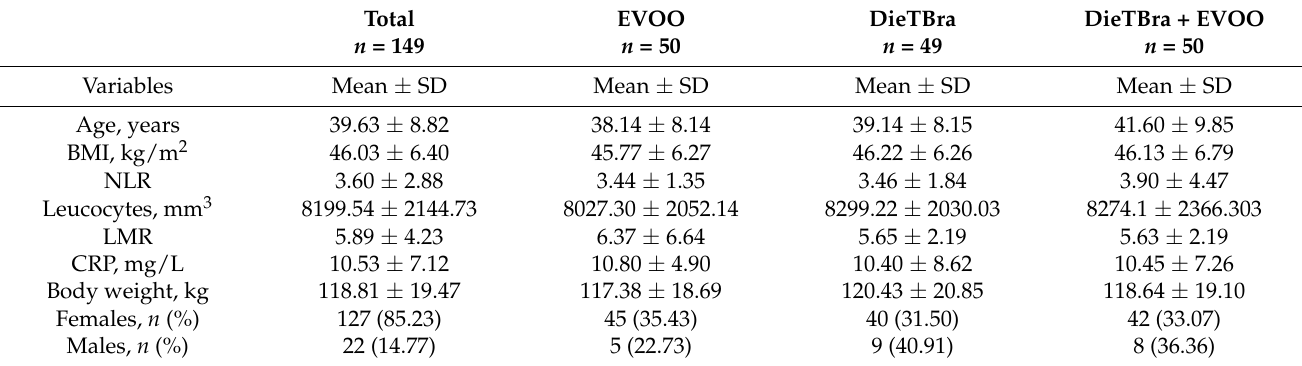
Table 1. Baseline characteristics according to the intervention groups in individuals with severe